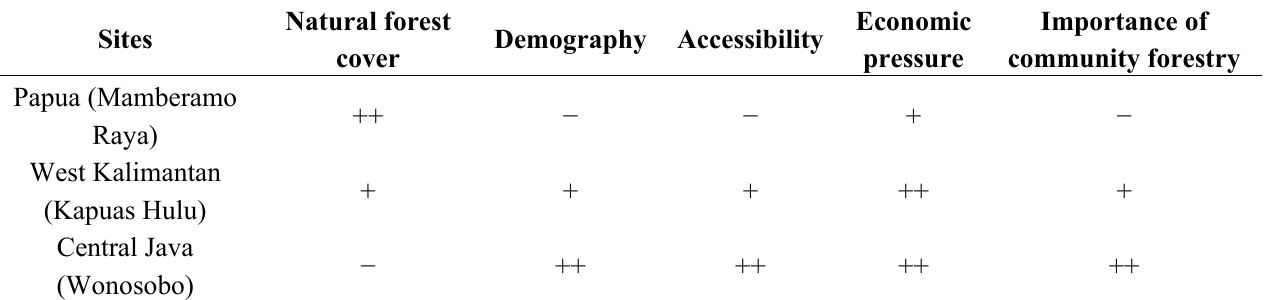
Table 1. Criteria for selecting research sites in